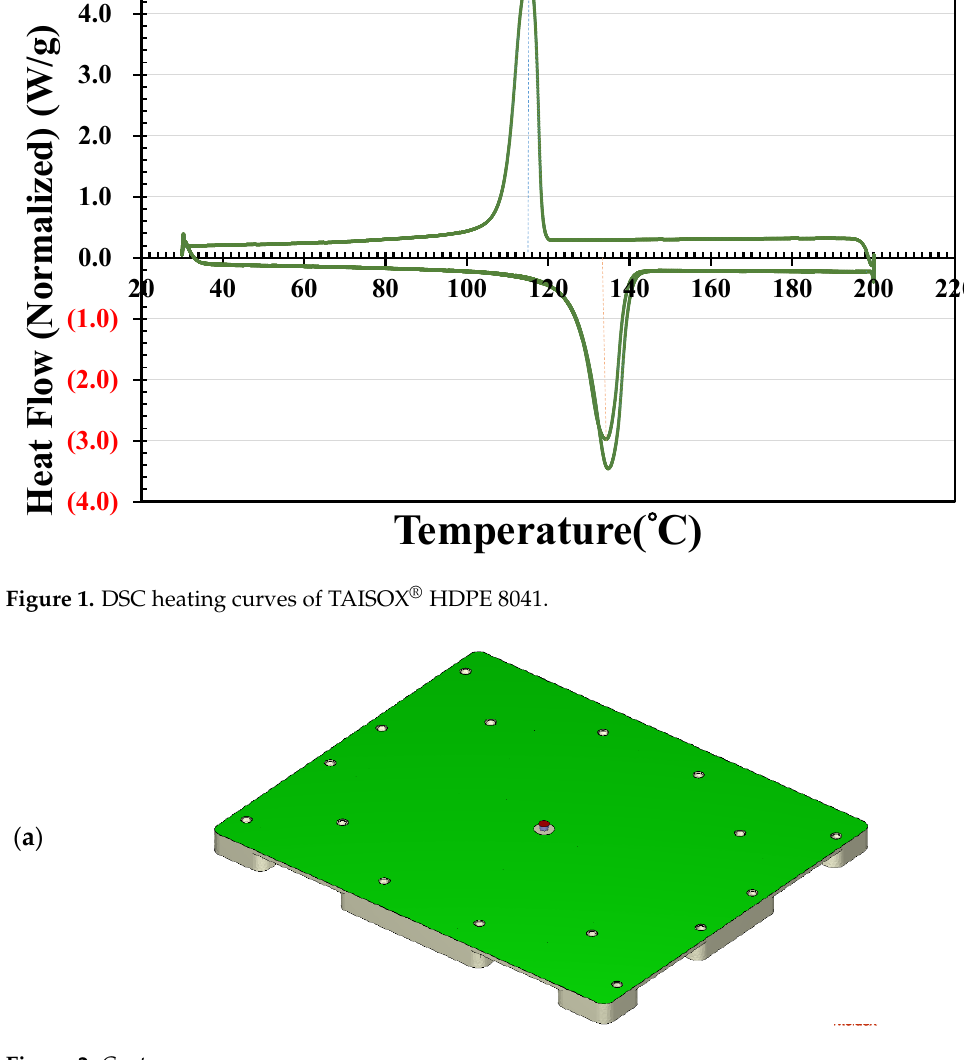
Figure 1. DSC heating curves of TAISOX ® HDPE 8041.